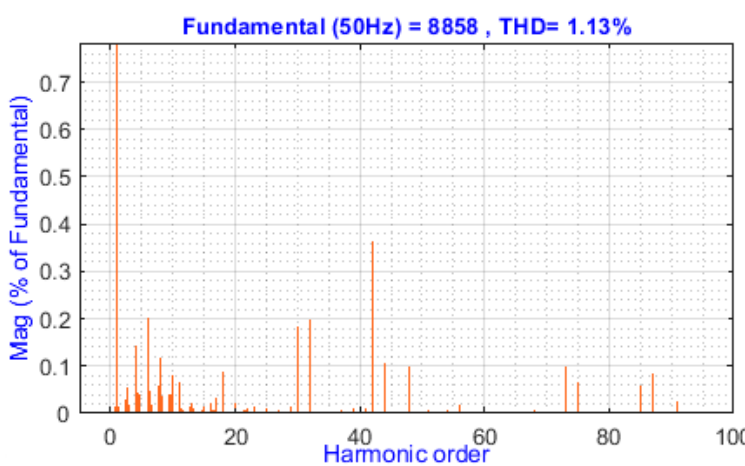
Figure 16. Total and individual harmonics level of the output current at PCC after filtering. To test the harmonics distortion at PCC under different levels of solar irradiation, the irradiation decreased from STC (1000 W/m 2 ) into 600 W/m 2 . It can be seen that the V THD and I THD values at the PCC were under the limits of the standard as shown in Figure 17 and Figure 18, respectively.